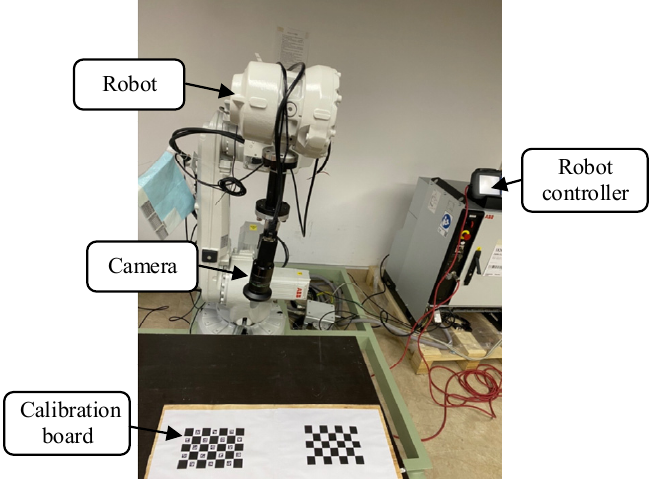
Figure 9. Hand–eye calibration experimental platform.